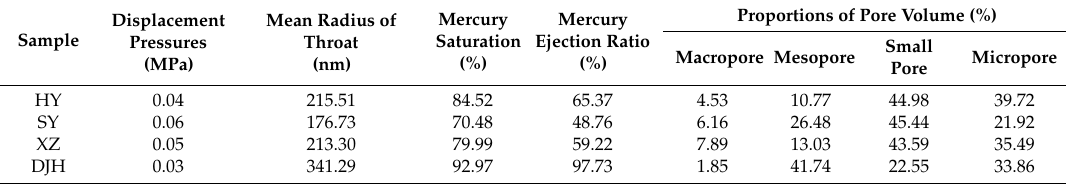
Table 3. Results of mercury intrusion experiments